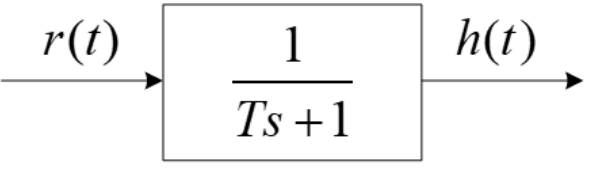
Figure 1. First-order model of governor delay.